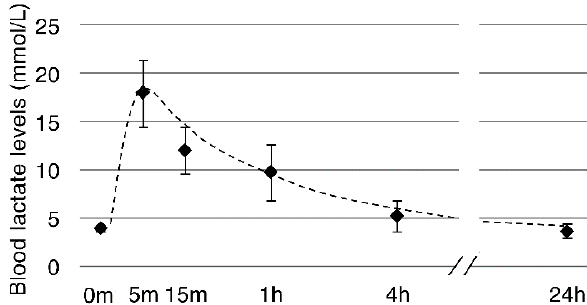
Figure 6. Blood lactate levels after intraperitoneal injection of lactate. Mice (eight weeks of age, n = 3) were intraperitoneally injected with sodium lactate (500 mg/kg). Blood lactate levels were measured with a blood lactate analyzer (Lactate Pro2; ARKRAY, Kyoto, Japan) at 0 min, 5 min, 15 min, 1 h, 4 h, and 24 h after injection. Results are expressed as mean ±